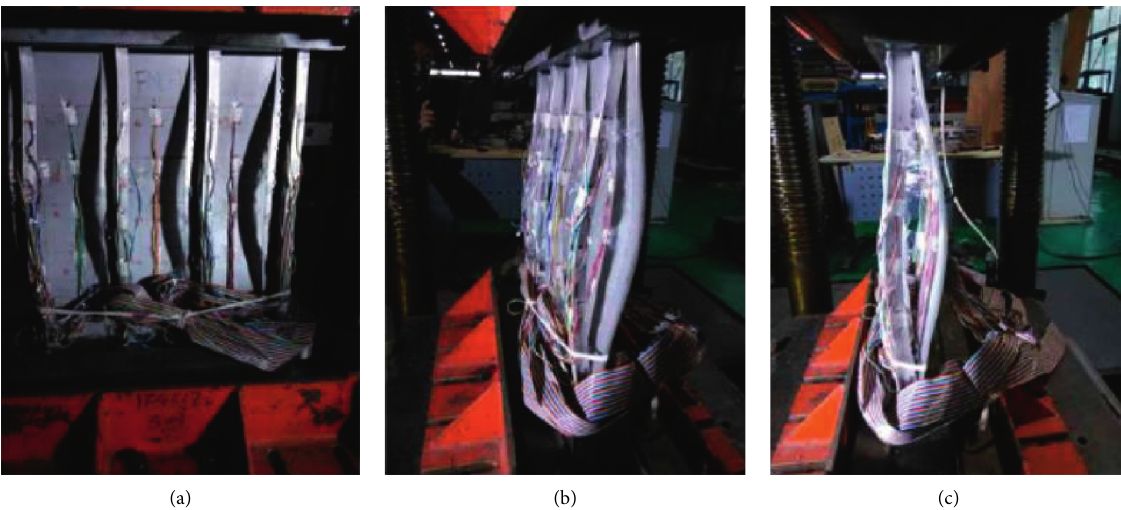
Figure 5: Destruction of fiber metal materials under axial compression stress [73]. (a) Skin buckling, (b) long buckling, and (c) overall instability of the